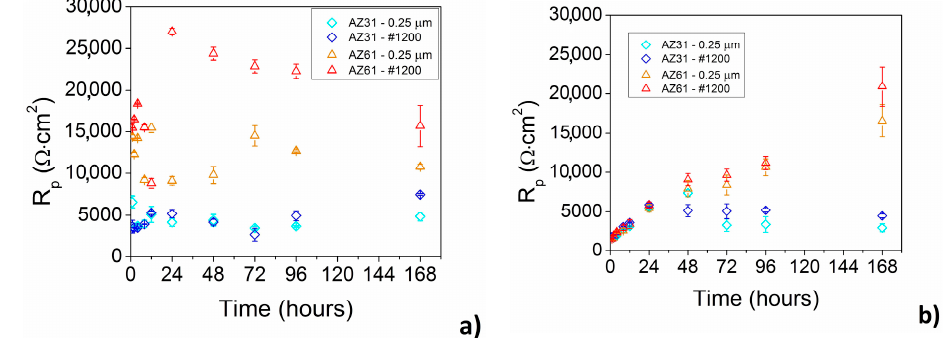
Figure 9. Polarization resistance R p of ground (#1200) and polished (0.25 µm) surface of AZ31 and AZ61 magnesium alloys: ( a ) in enriched HBSS+ (with Mg 2+ and Ca 2+ ions) and ( b ) in HBSS (without Mg 2+ and Ca 2+ ions [32]).